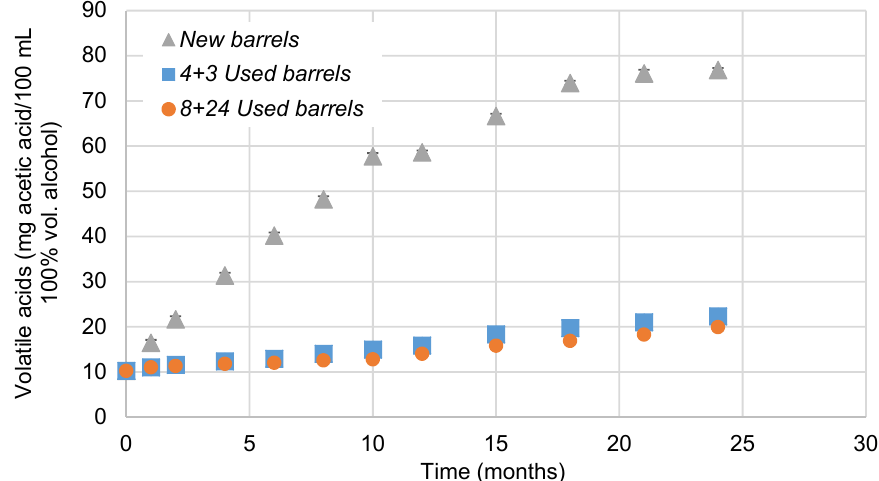
Figure 2. Evolution of volatile acids in brandies aged in New barrels , 4 + 3 Used barrels , and 8 + 24 Used barrels for two years. When the standard deviation was lower than 0.8 cannot be noticed in the graph.